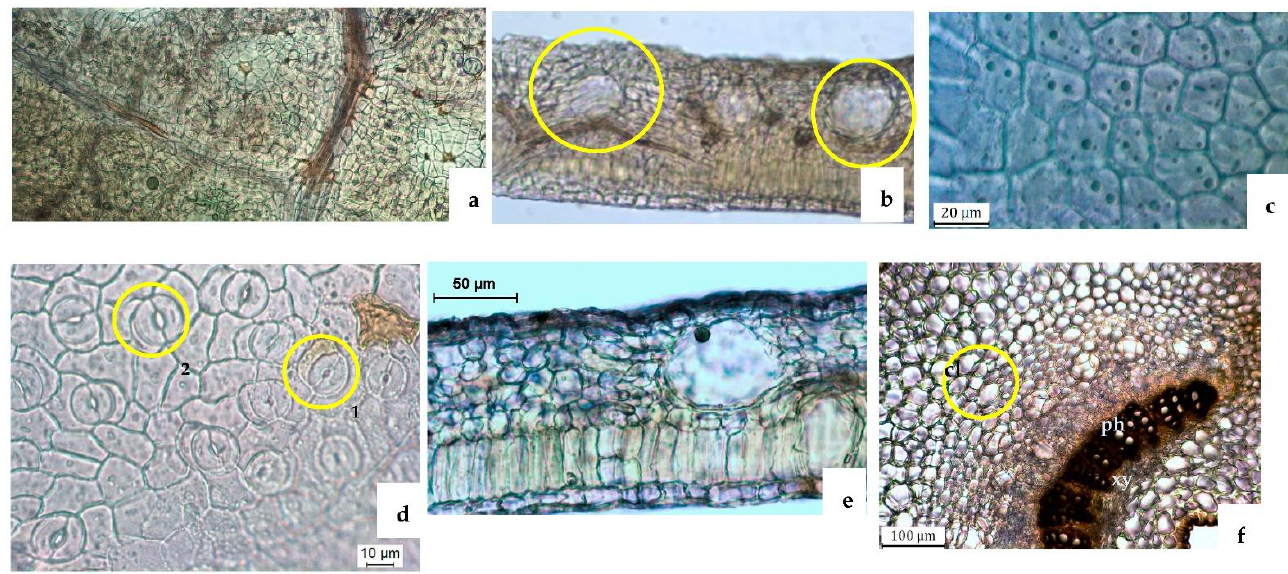
Figure 3. Light microscopy photographs of the H. foliosum leaf surface ( a – d ) and transverse section ( e , f ). ( a ) Adaxial surface view showing secondary veins forming a right angle with the primary veins, reticulated secondary venation, and translucent oil glands; ( b ) abaxial surface view showing translucent oil glands; ( c ) adaxial epidermal cells; ( d ) abaxial epidermal cells with corrugated walls and two types of stomata (1 — anomocytic; 2 — anisocytic); ( e ) leaf transverse section showing the bifacial mesophyll details; ( f ) transverse section of midrib showing circularly shaped collenchymatous cells and type B secretory canals, with a visible lumen scattered in the phloem, surrounded by four flattened cells (ph — phloem, xy — xylem).